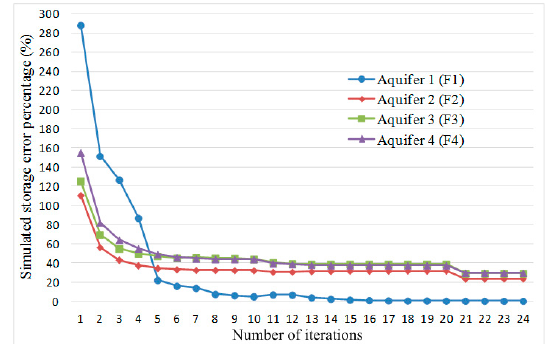
Figure 9. Simulated storage error percentages vs. number of iterations for the Chou-Shui River alluvial fan groundwater system.